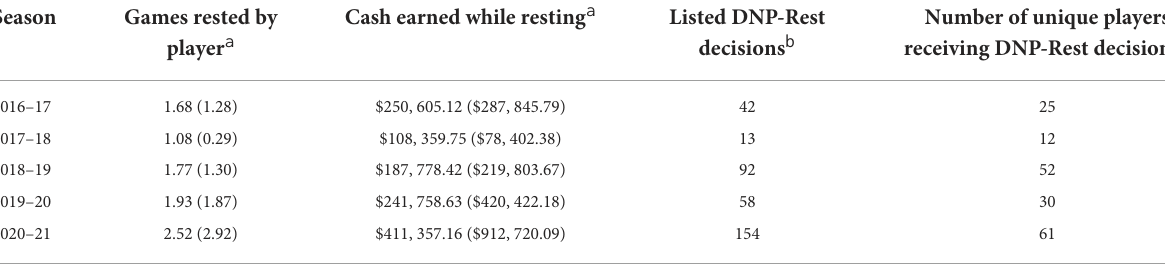
TABLE 1 Listed DNP-Rest decisions across sample period (2016–17 to 2020–21).